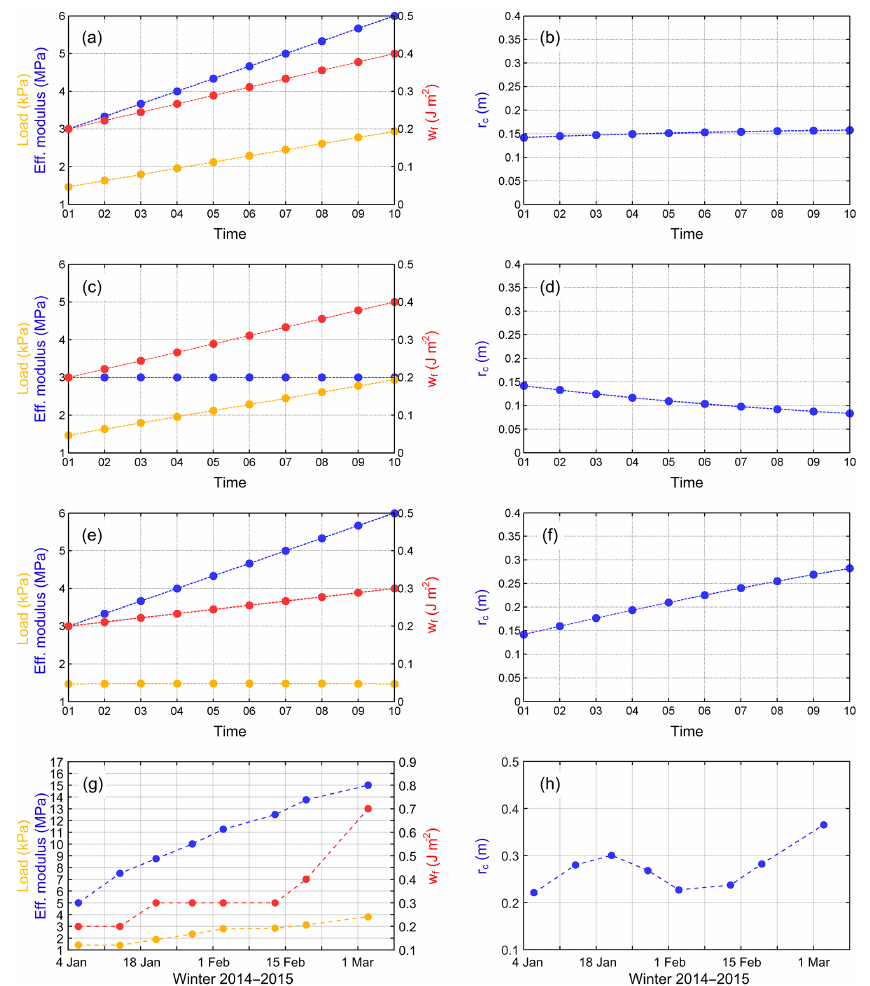
Figure 7. Case studies on how the critical cut length r c varies as a function of the load and the effective modulus of the slab and the specific fracture energy of the weak layer w f . Arbitrary units of time for the three simplified scenarios shown in (a) – (f) . In the last scenario (g, h) , the situation during the sampling period is supposed to be roughly